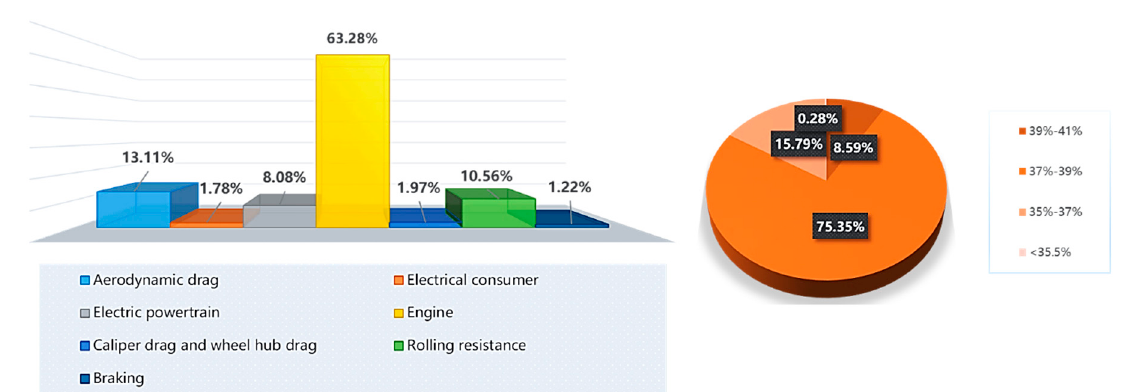
Figure 7. CS energy consumption and engine performance of NEDC.